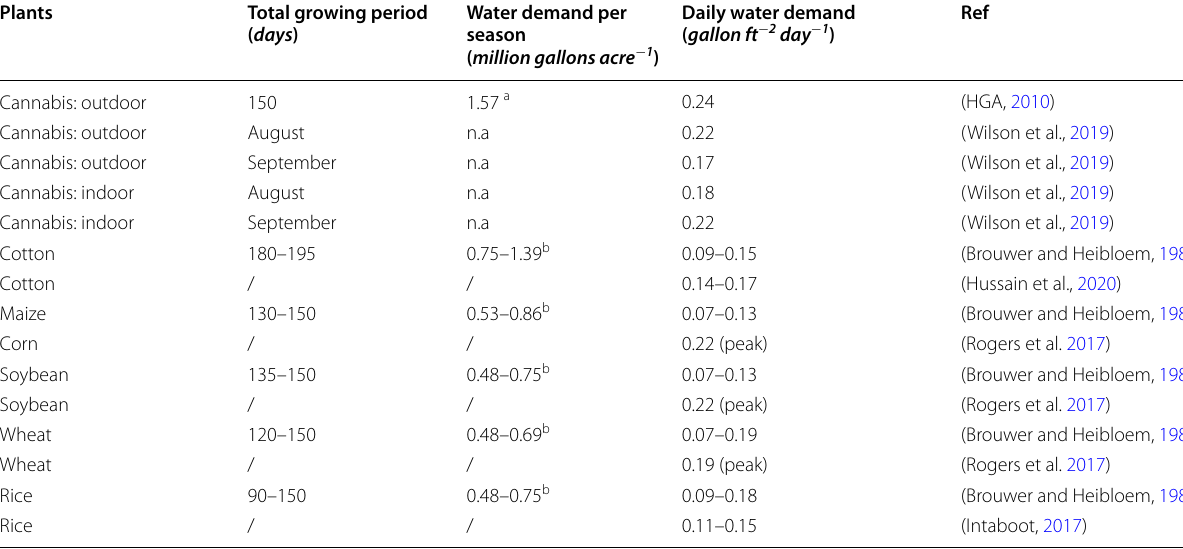
Note a : The water demand of cannabis is calculated based on 22.7 l (6 gallons) of water per day during the growing season and 200 plants per 5,000 sq. ft (HGA, 2010) Note b : The water demand of crops is based on crop water need from Table 14 in Brouwer Heibloem (Brouwer and Heibloem, 1986). We convert the unit from mm to million gallon acre − 1 according to the rule of unit conversion where 1 acre inch is equivalent to 27,154.29 gallon